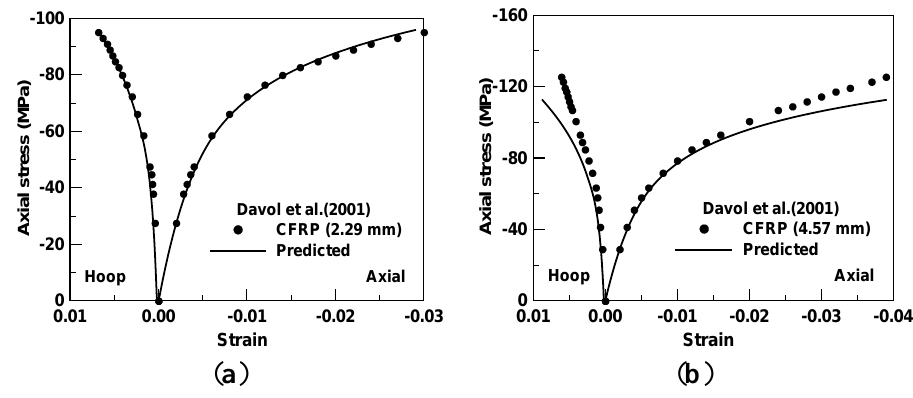
Figure 5. ( a ) Prediction of compression test for CFRP thickness of 2.29 mm; and ( b ) prediction of compression test for CFRP thickness of 4.57 mm.